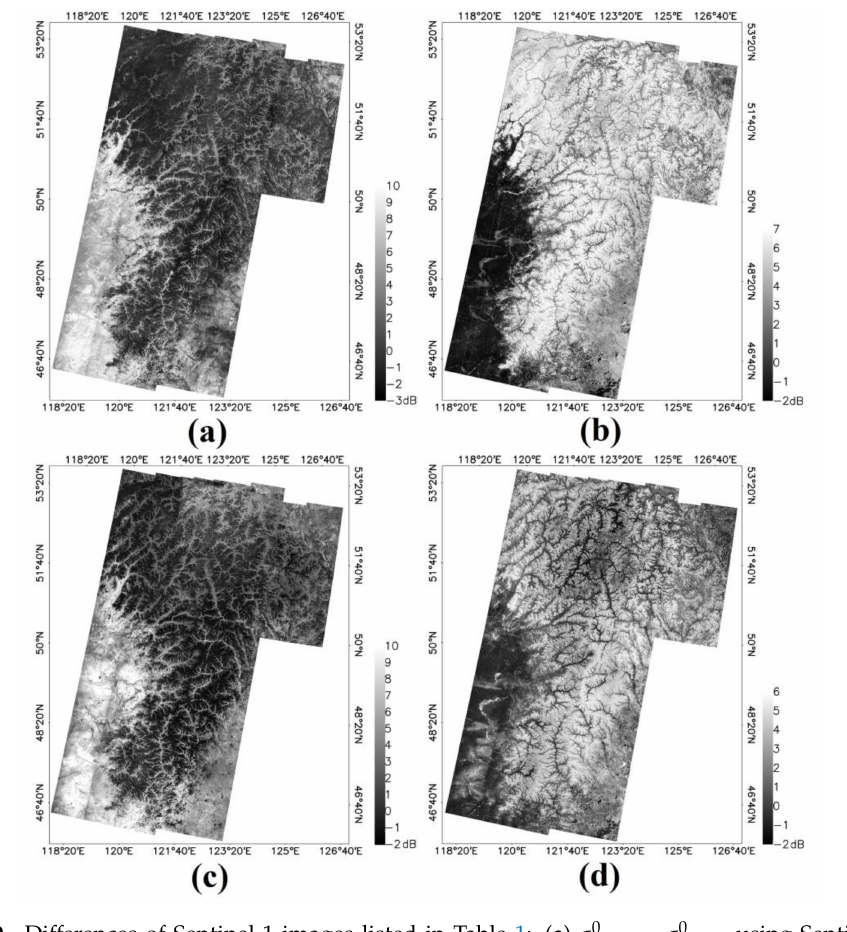
Figure 9. Di ff erences of Sentinel-1 images listed in Table 1: ( a ) σ 0 − σ 0 in 2015; ( b ) σ 0 using Sentinel-1A in 2015; ( c ) σ 0 Date 2 Date 3 − σ 0 ( d ) σ 0 using Sentinel-1B in Date 2 Date 3